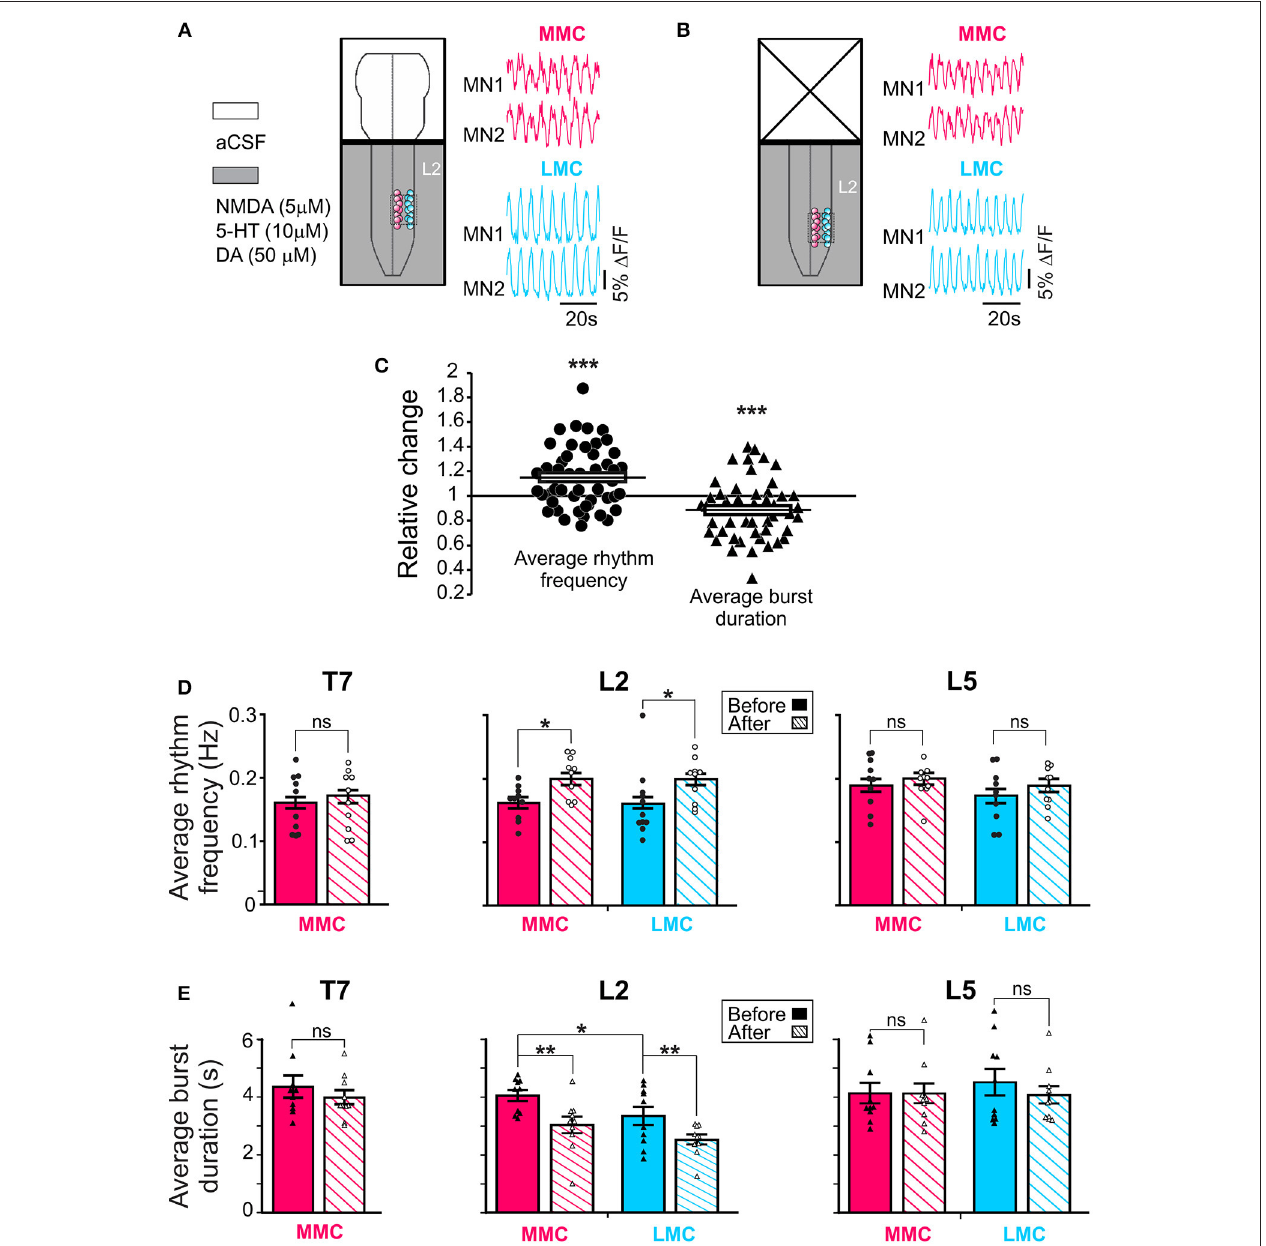
FIGURE 2 | Regulation of the locomotor rhythm frequency and burst durations by the brain stem. Schematic representations of the experimental arrangement before (A) and after (B) removal of the brain stem shown together with corresponding set of waveforms displaying changes in fluorescence in two L2 MMC MNs (red) and two L2 LMC (blue) MNs (for other details, see Figure 1A ). The same four MNs are shown in the two panels. (C) Pooled data from 50 motor columns (10 motor columns in T7, 20 motor columns in L2 and in L5) showing relative change in average rhythm frequency (solid circles) and burst duration (solid triangles) after removal of the brain stem. (D,E) Bar graphs showing the average rhythm frequency and average burst duration in MMC (red) and LMC MNs (blue) in the individual segments before and after removal of the brain stem (solid and hatched bars, respectively). Each bar is a grand average across all experiments. The increase in rhythm frequency after removal of the brainstem was statistically significant in L2 (paired t -test, L2 MMC before vs. MMC after p = 0.003; L2 LMC before vs. LMC after p = 0.048; T7 MMC before vs. MMC after p = 0.79; L5 MMC before vs. MMC after p = 0.86; L5 LMC before vs. LMC after p = 0.26). Removal of the brain stem also significantly reduced the average burst durations in L2 (paired t -test, L2 MMC before vs. MMC after p = 0.003; L2 LMC before vs. LMC after p = 0.004; T7 MMC before vs. MMC after p = 0.26; L5 MMC before vs. MMC after p = 0.97; L5 LMC before vs. LMC after p = 0.34). * p < 0.05, ** p < 0.01, *** p < 0.001.